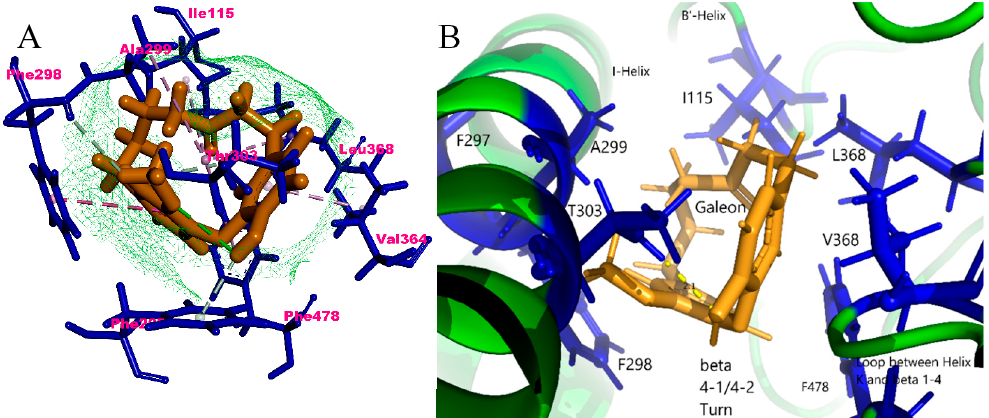
Figure 6. ( A ) 2D interaction mechanism of CYP2E1-galeon; ( B ) 3D interaction mechanism of